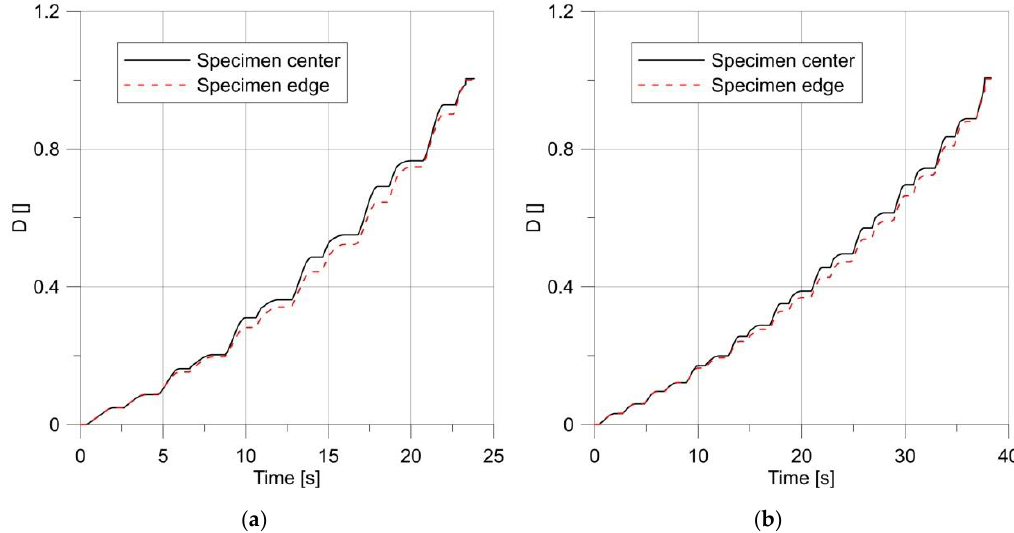
Figure 20. Changes in parameter D for a smooth round specimen with a regular load ( a ) and a reduced load ( b ).